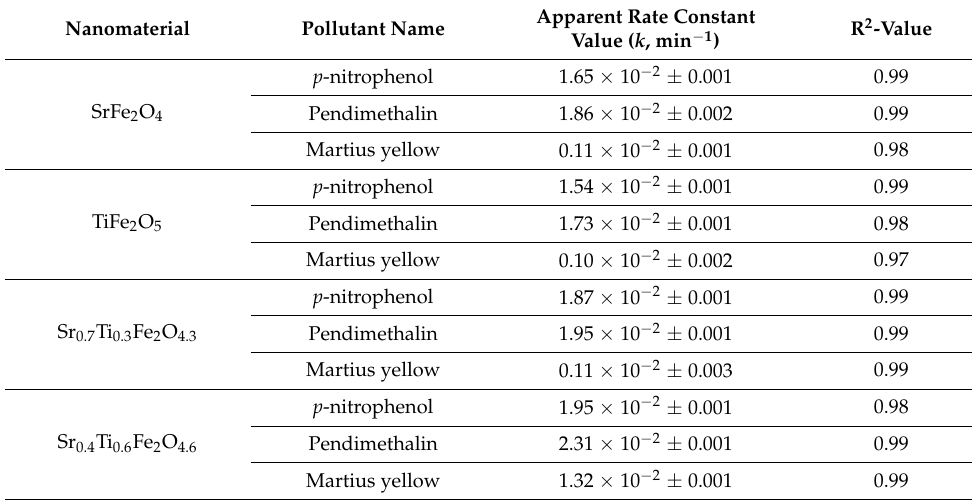
Table 5. Values of apparent rate constant and regression coefficient values for nitroaromatic